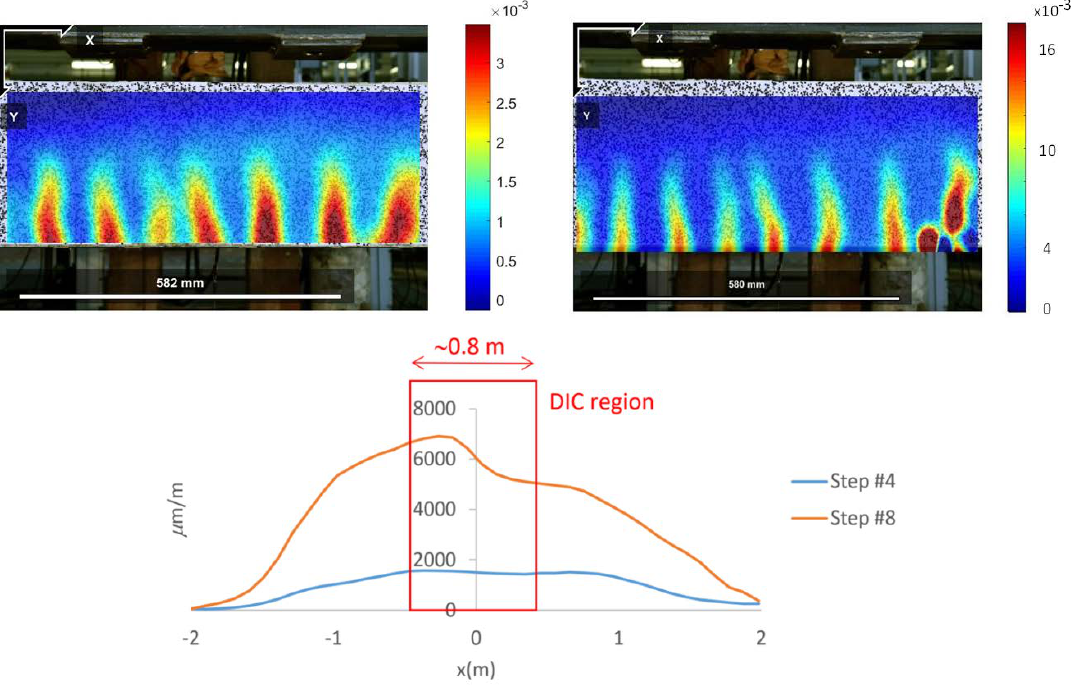
Figure 15. DIC ( top ) and FOS #2 ( bottom ) outcomes at loading steps #4 (top-left) and #8 (top-right) in Figure 15. DIC (top) and FOS #2 (bottom) outcomes at loading steps #4 (top-left) and #8 (top-right) in the central area of the beam specimen (between the vertical loads—see Figure the central area of the beam specimen (between the vertical loads – see Figure 2).